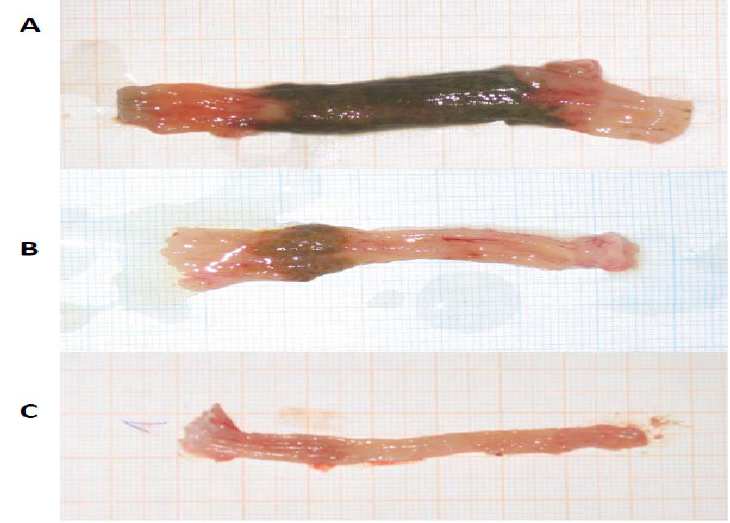
Figure 4. ( A ) Area of colon mucosal lesions induced by TNBS, with necrotic areas (72%). Control animal treated with 0.9% NaCl. ( B ) Area of colon mucosal lesions induced by TNBS, with necrotic areas (23%). Animal treated with β -MSH (0.250 mg/kg b.w.). ( C ) Native control, colon without necrotic areas.